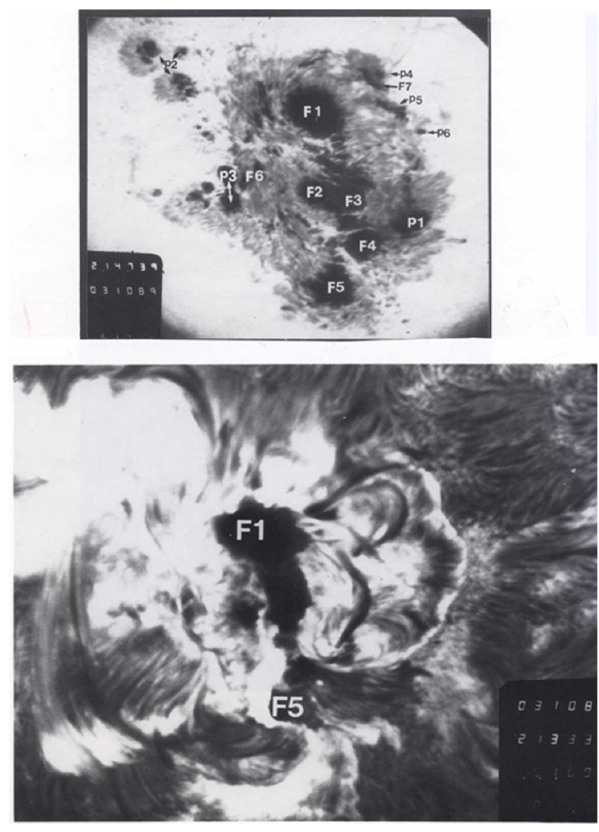
Fig. 22b. A typical complex flare (courtesy of the Big Bear Solar